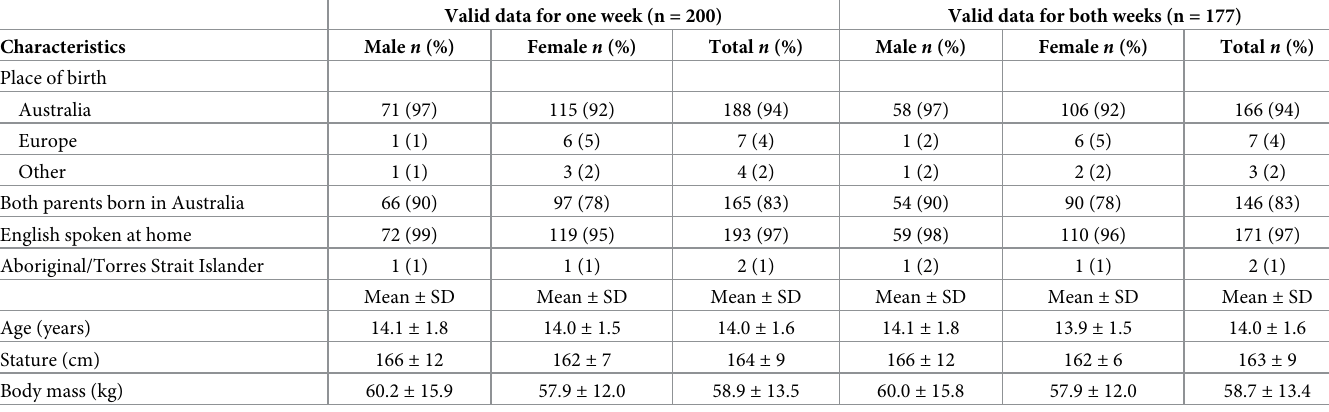
Table 1. Characteristics of participants included for both phases of the